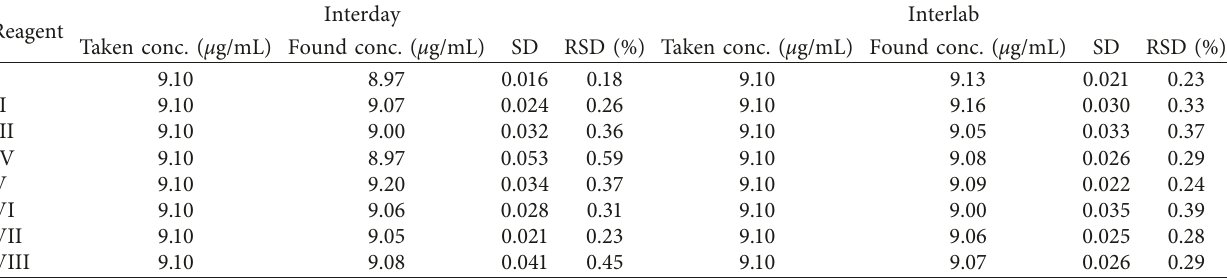
Table 2: The ruggedness and the repeatability data of the method. Interday Interlab Reagent Taken conc. ( μ g/mL) Found conc. ( μ